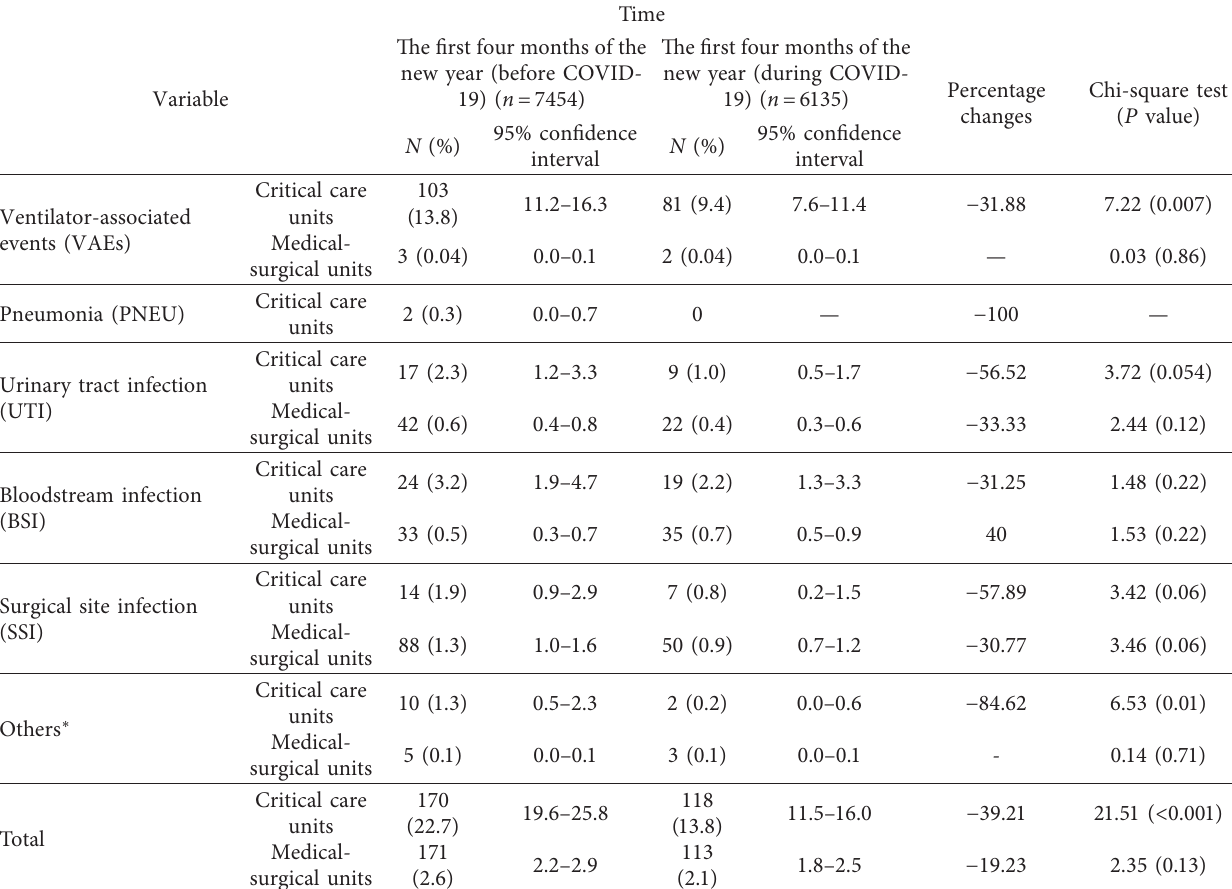
Table 2: The nosocomial infection rate before and during COVID-19 outbreak in critical care units and medical-surgical units.